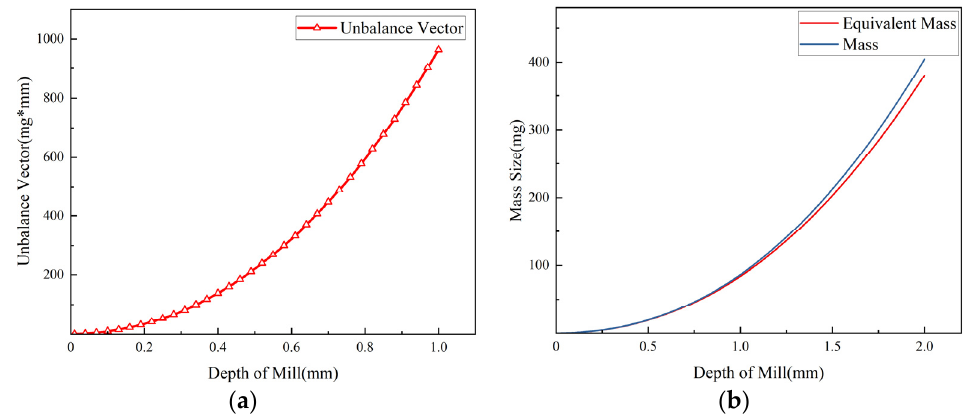
Figure 13. Depth of mill diagram: ( a ) relationship between unbalanced vector and milling depth; ( b ) relationship between mass and equivalent mass. ( b ) relationship between mass and equivalent